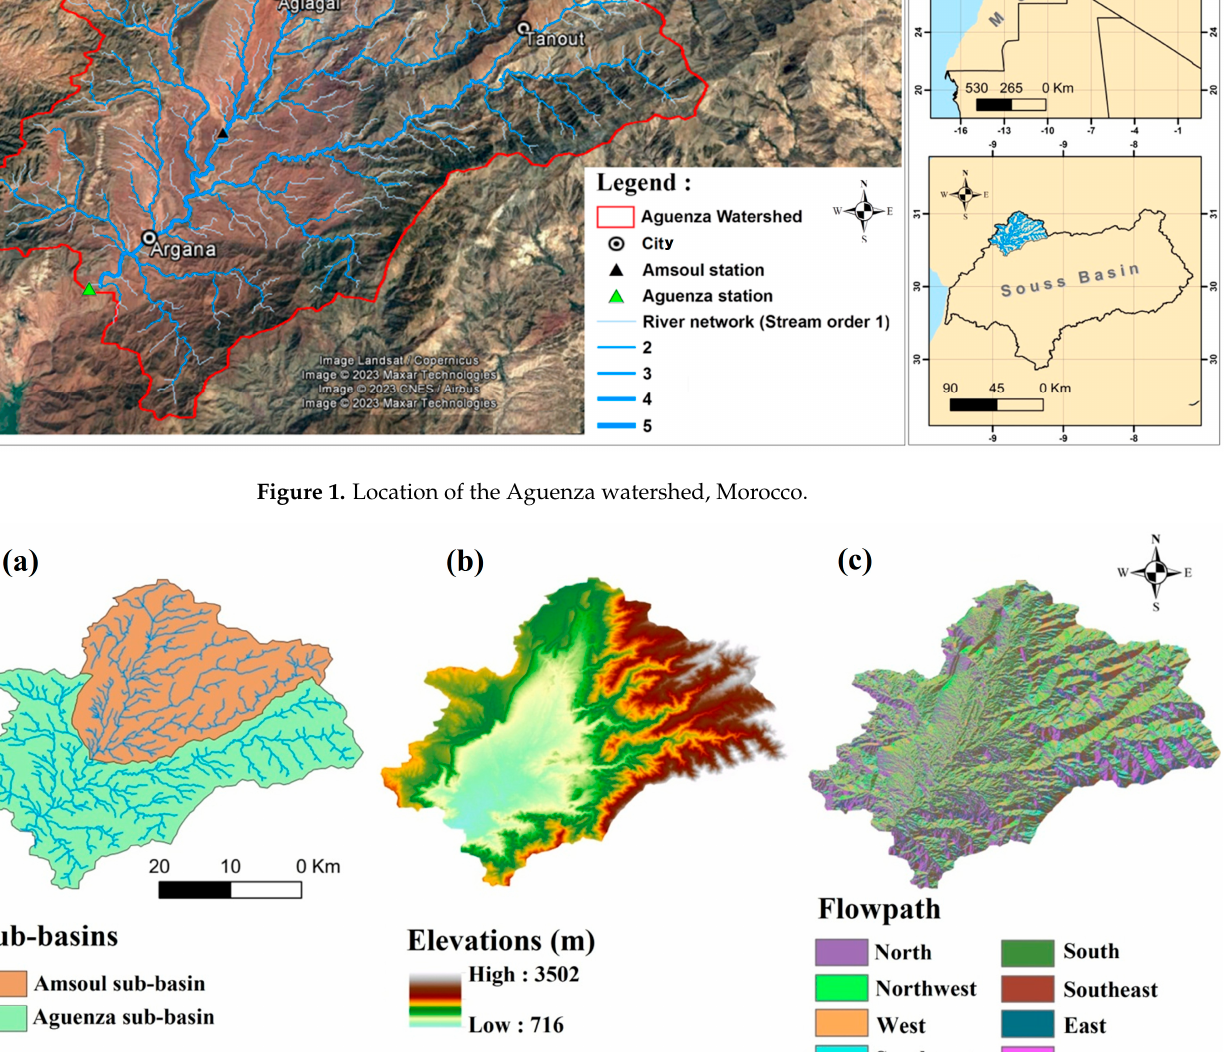
Figure 1. Location of the Aguenza watershed, Morocco.